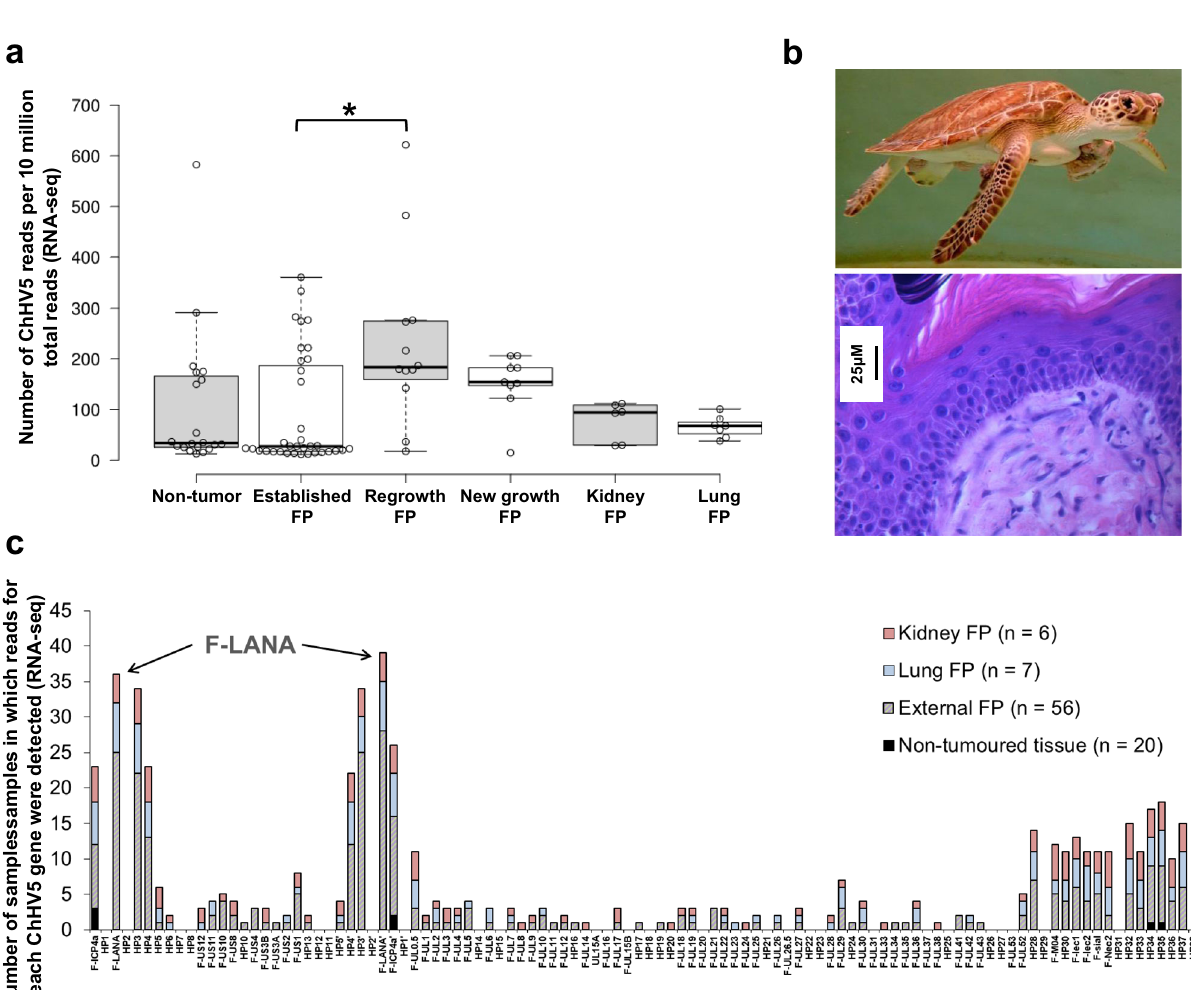
Fig. 3 Transcriptomics of ChHV5 in external and internal FP tumors, and non-tumor tissue samples. a ChHV5 expression across each sample type. Box plot with Tukey whiskers of the number of ChHV5 reads (RNA-seq) per 10 million total reads per sample. Individual sample values within each sample type are shown by the open points. Signi fi cant differences in averages between sample types were determined by a Kruskal – Wallis with Dunn – Bonferroni post hoc test and are denoted by an asterisk (*). Per sample type: non-tumor n = 20, established external tumor n = 35, regrowth external tumor n = 12, new growth external tumor n = 9, kidney tumor n = 6, lung tumor n = 7. b Top: Rehabilitating FP-af fl icted juvenile green sea turtle. Image credit: Nancy Condron. Bottom: Hematoxylin and eosin stained fi bropapillomatosis tumor, external regrowth tumor. c Total number of samples in which reads (RNA- Seq) for each ChHV5 gene were detected. A gene was counted as detected if a sample had TPM-normalized counts >0 for said ChHV5